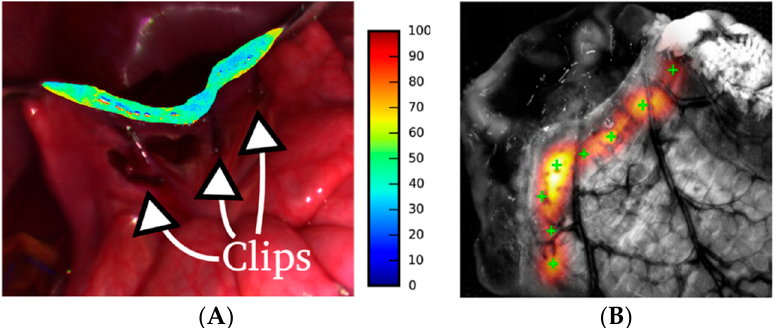
Figure 7. HSI application in Bowel anastomosis. ( A ) Small bowel oxygenation estimation shown in [68]; ( B ) Suture map and recommendations about the location of the suture provided in [69].